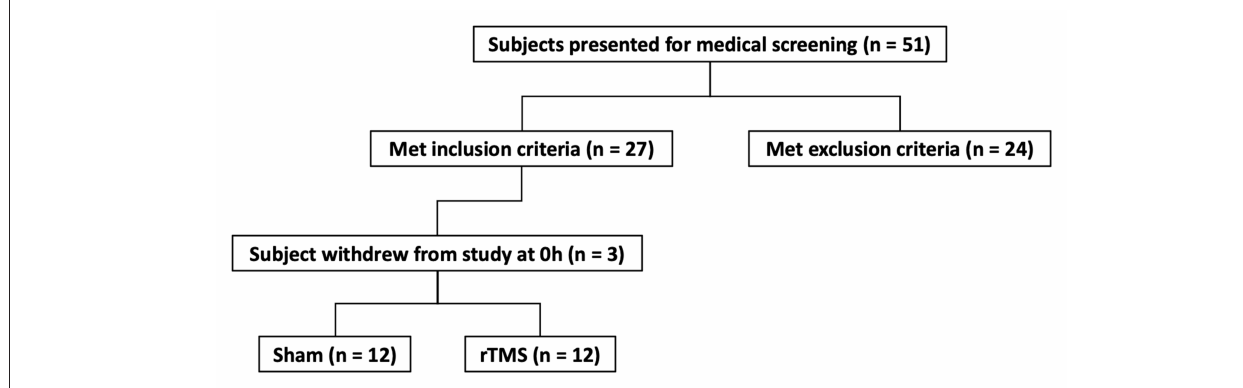
FIGURE 1 | Flow chart of eligible participants and randomization to Sham or rTMS group.